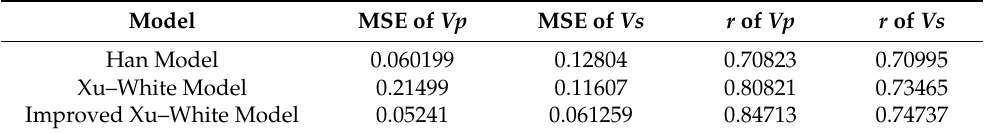
Figure 7. The prediction results of P-wave and S-wave velocities based on the improved Xu–White model (red is forecast speed, black is actual speed). Table 2. The mean square error (MSE) and correlation coefficient ( r ) of Vp and Vs predicted by different models.